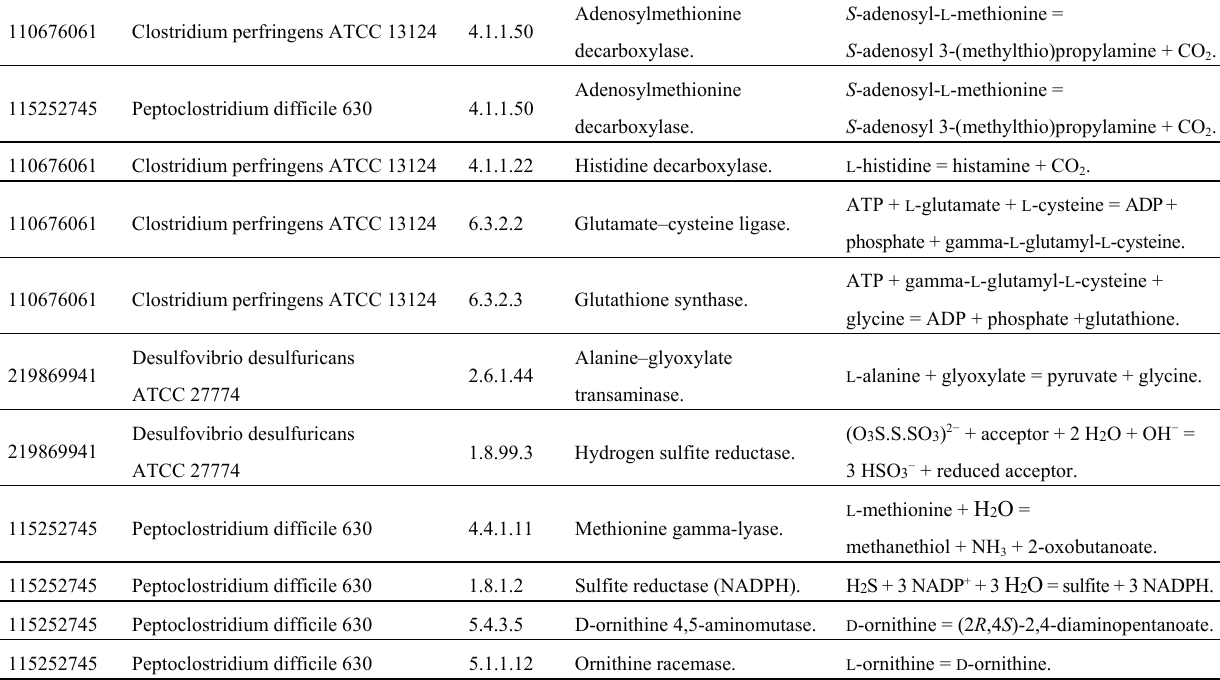
Table 9. Enzymes of interest coded by the “autism” microbiome; Query 1.